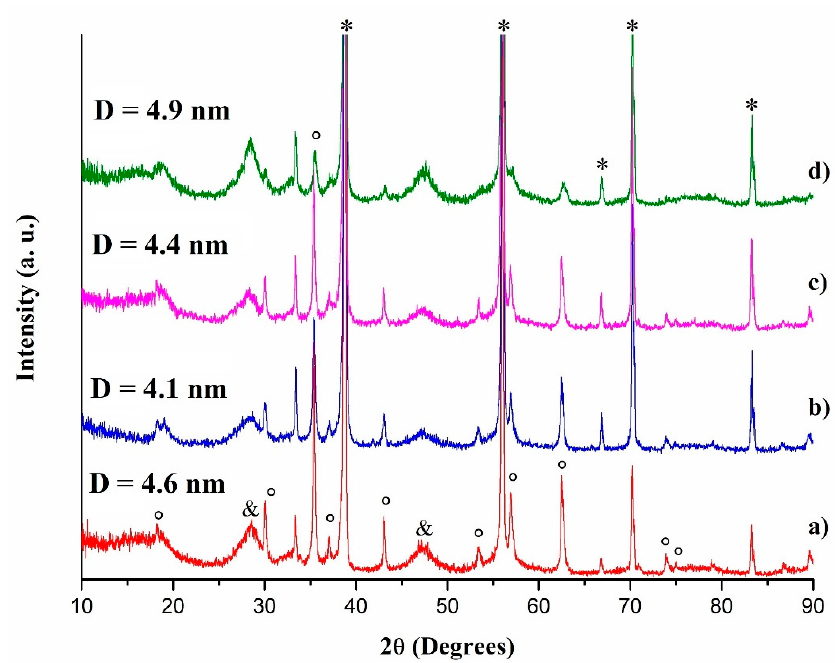
Figure 8. XRD patterns of samples calcined at 550 °C: a ) Fe 3 O 4 /1.5CeO 2 (red line); b ) Fe 3 O 4 :CITR/1.5CeO 2 (blue line); c ) Fe 3 O 4 :PVP/1.5CeO 2 (magenta line); d ) Fe 3 O 4 :OA/1.5CeO 2 (green line). The marked peaks belong to: * NaF (support); ° magnetite; & ceria. D is the particle size of crystalline ceria, calculated by the Scherrer formula based on the strongest peak (111) of CeO 2 at ca. 2 θ = 28.5°.